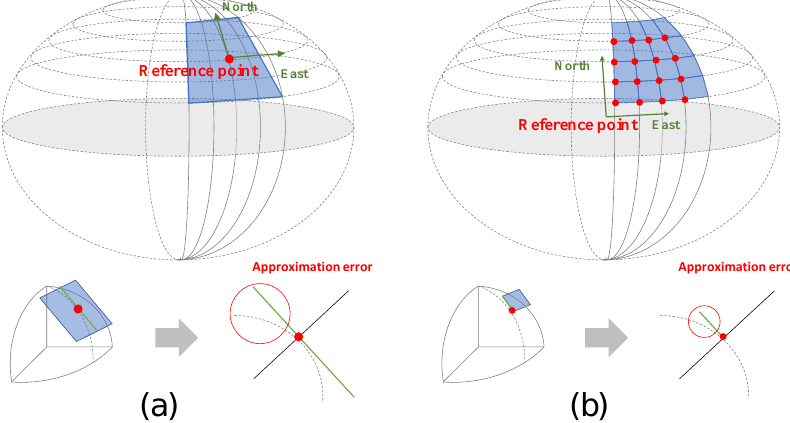
Figure 5. Coordinate conversion between geodetic coordinate and Cartesian coordinate for mapping of global EOGM. Plane approximation ( a ) without the quad-tree tile and ( b ) with the quad-tree